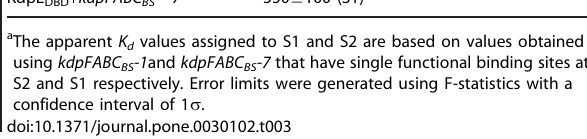
Figure 7. Bindinganalysisofthehalf-sitesofkdpFABC BS . SE analysis of binding of KdpE DBD to S1 ( kdpFABC BS —7 ) ( A )and S2 ( kdpFABC BS — 1 ) ( B ) half-sites revealed a 1:1 stoichiometry. Mixtures of KdpE DBD and DNA were spun at 9,000 ( KdpE DBD binding at half-sites S1 was 350 6 100 nM and for S2 was 200 6 100 nM using a one site binding model (AB) in SEDPHAT. The molecular weights calculated from the SE data were 30,000 6 1,500 for kdpFABC BS —1 and 30,000 6 2,500 for kdpFABC BS —7 .